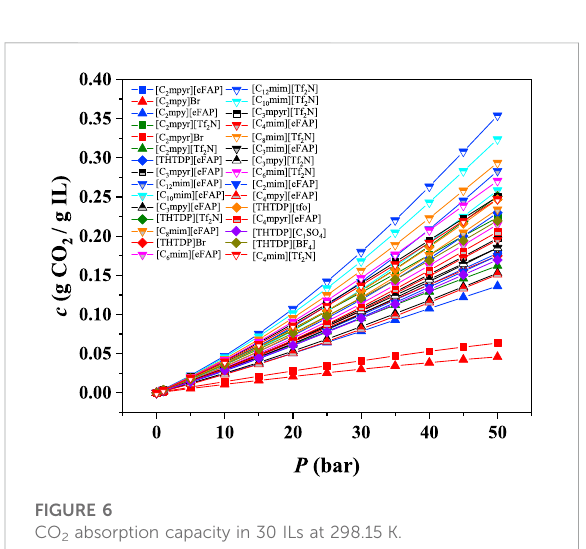
FIGURE 6 CO 2 absorption capacity in 30 ILs at 298.15 K.